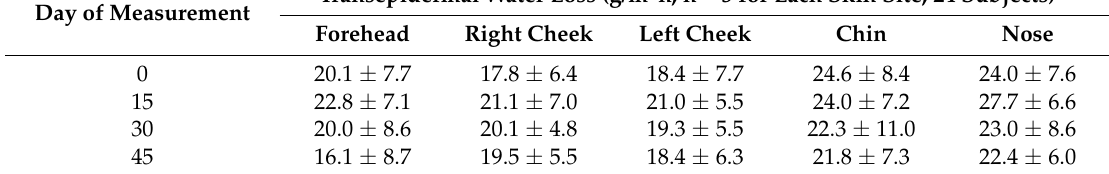
Table 5. Average results of the evaluation of skin barrier function on the forehead, the right cheek, the left cheek, the chin, and the nose of volunteers.